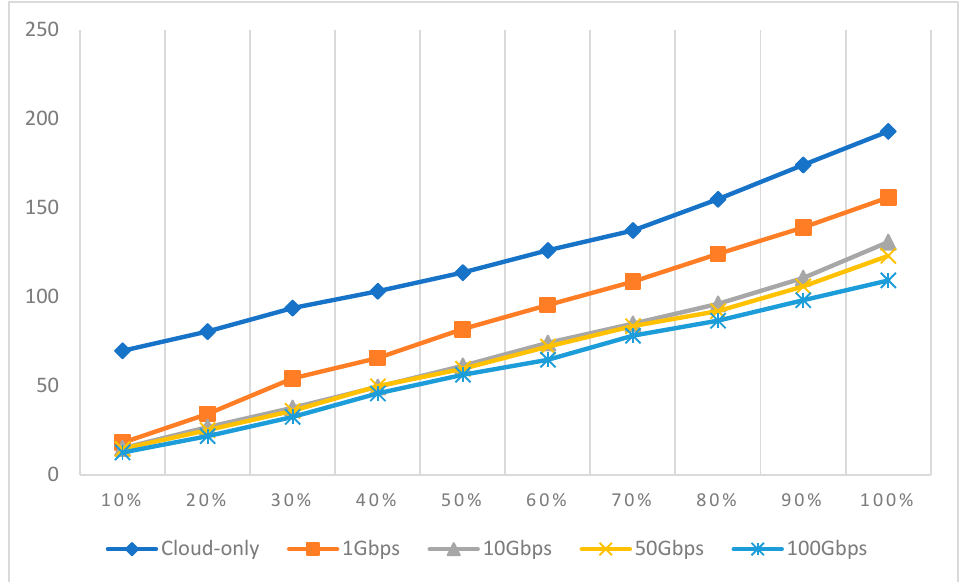
Figure 11. Cloud–edge schemes with 80% computing resources are available in the cloud.